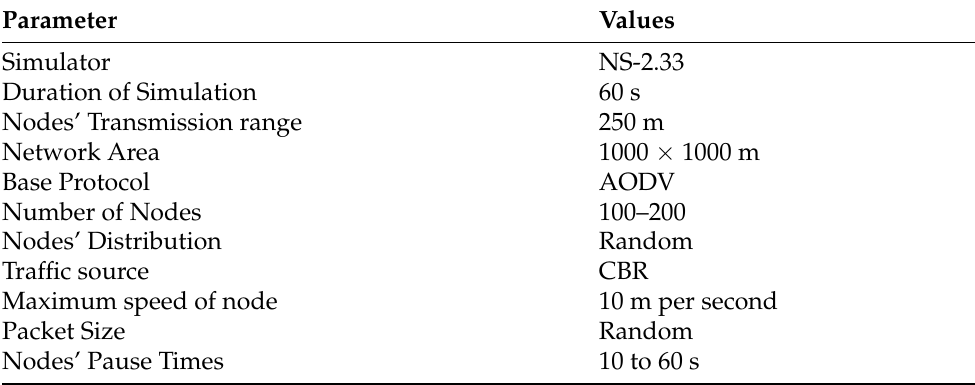
Table 2. Parameters for experimental